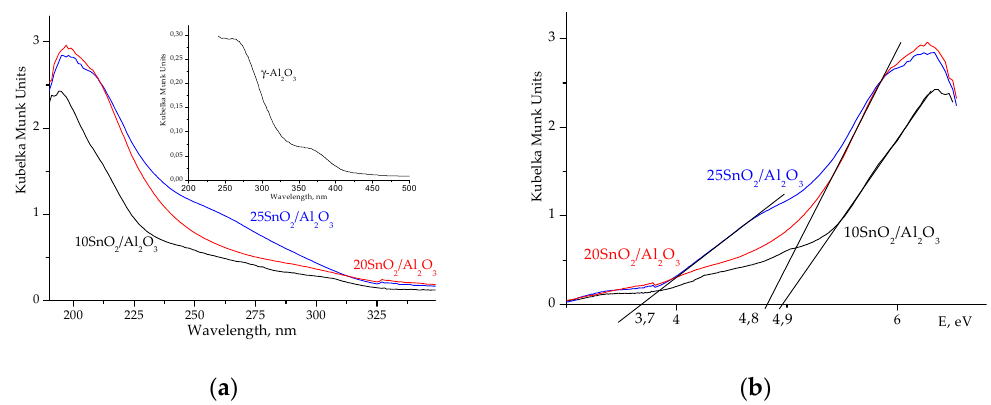
Figure 4. UV-Vis diffuse reflectance spectra of z SnO 2 /Al 2 O 3 samples with different Sn loading ( a ); optical energy band gap ( b ).